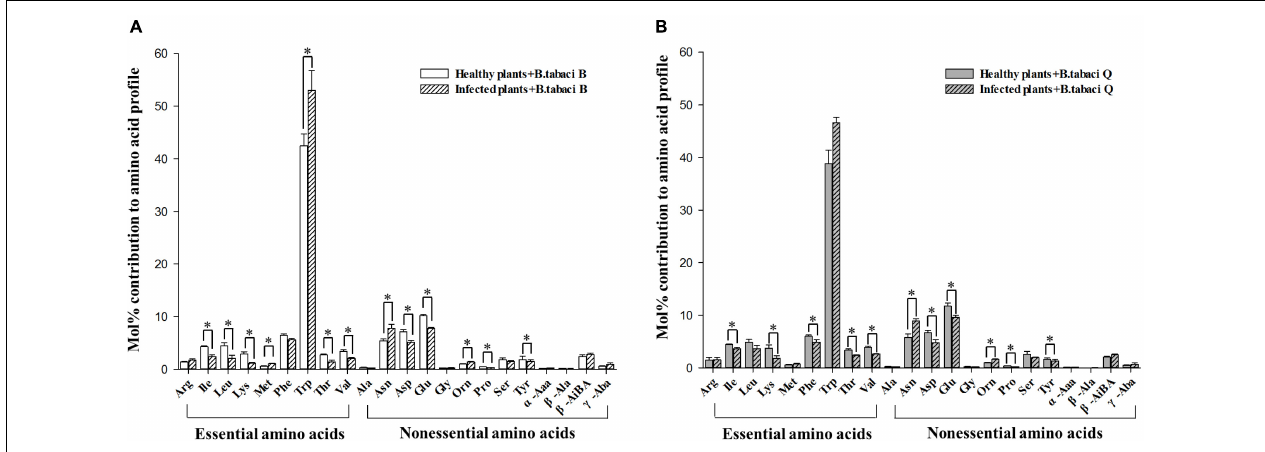
FIGURE 3 | The mol% of free amino acids in the honeydew of (A) B. tabaci B adults and (B) B. tabaci Q adults that fed on healthy and TYLCV-infected tomato plants. Value are means ( ± SE) of three replicates. ∗ Indicates a significant difference between healthy and infected plants at P < 0.05; LSD test. For abbreviations, see Table 1